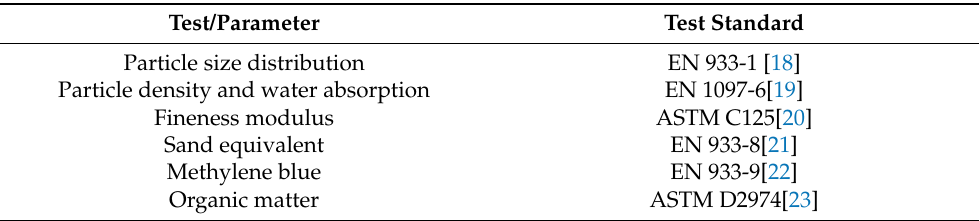
Table 1. Test methods used for the geotechnical characterization of scoria.